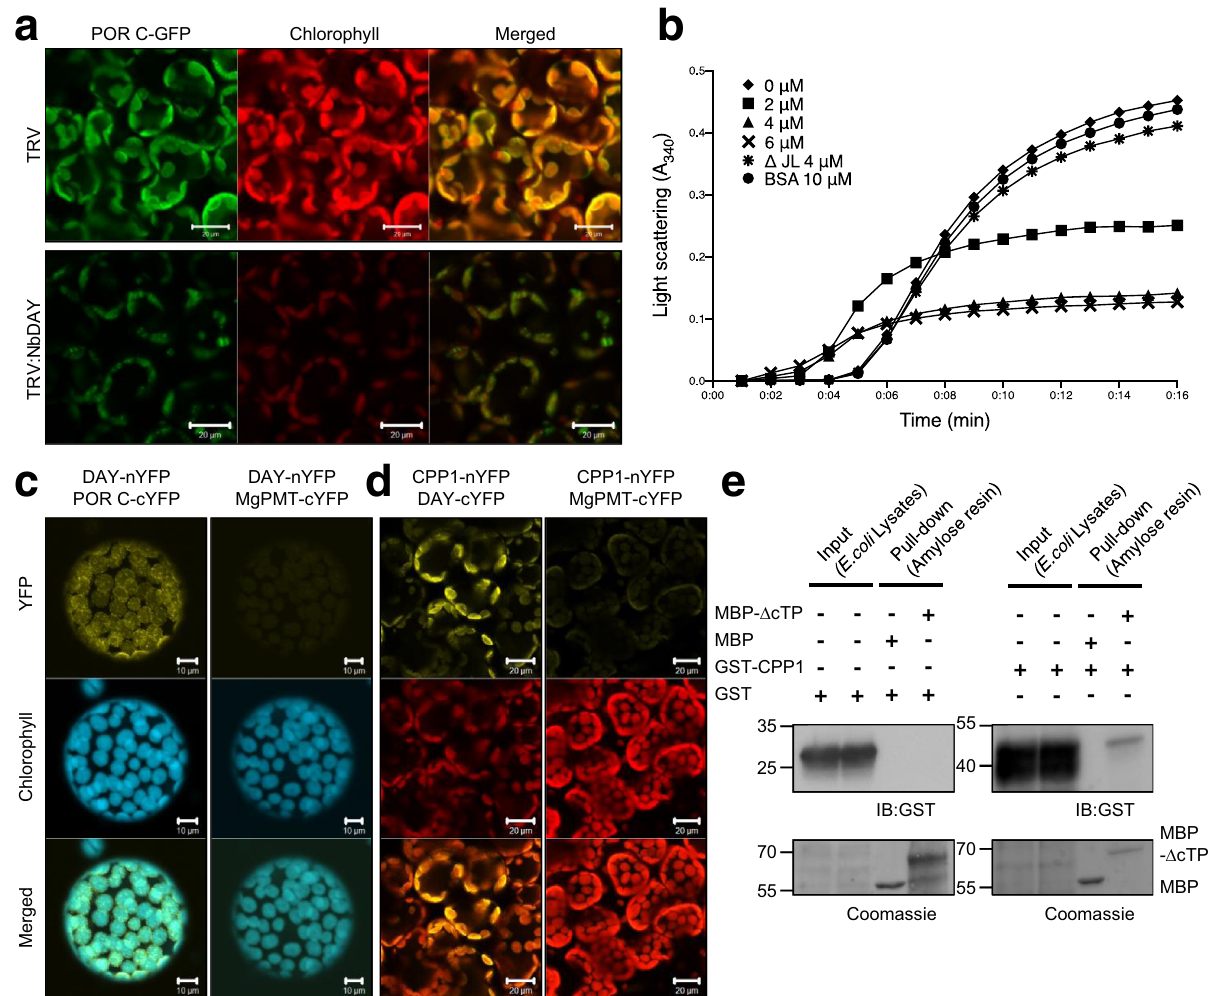
Fig. 3 Together with CPP1, DAY regulates the stability of protochlorophyllide oxidoreductase (POR) through its holdase chaperone activity. a Reduction of DAY causes POR instability in N. benthamiana . Virus-induced gene silencing (VIGS) of N. benthamiana DAY ( NbDAY ) was performed. Then the VIGS plants (TRV:NbDAY) were agroin fi ltrated with the POR C-GFP construct, and leaf mesophyll cells were examined by CLSM. POR C is a major POR isoform in light-grown Arabidopsis. NbDAY silencing caused a signi fi cant reduction in chlorophyll auto fl uorescence and POR C-GFP fl uorescence. Scale